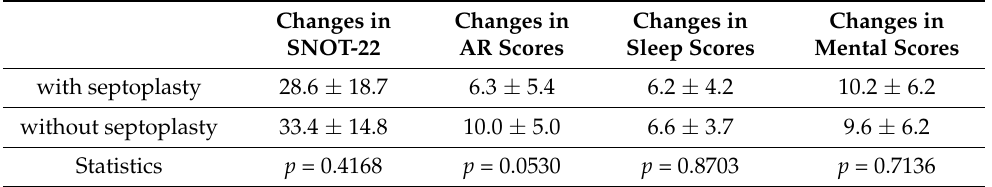
Table 3. Changes in SNOT-22, AR, sleep, and mental scores in subjects showing sleep and mental disorders with or without septoplasty.